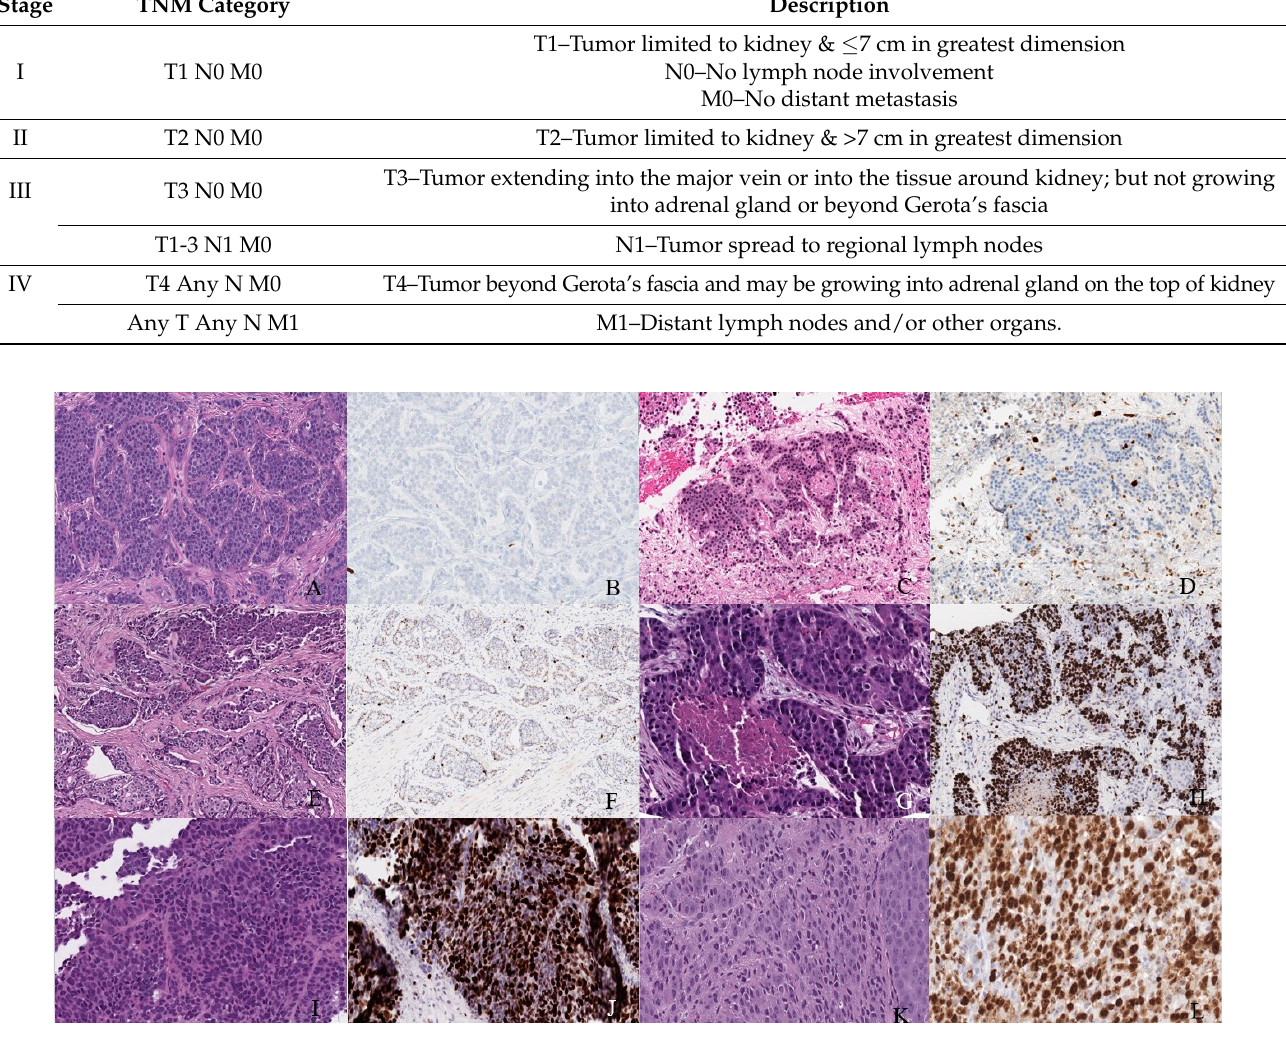
Figure 7. Well-differentiated NET (neuroendocrine tumor). ( A ) Grade 1 shows packets of neuroen- docrine cells separated by fibrovascular tissue. ( B ) Ki67 immunohistochemical stain shows a prolif- eration rate of 1%. Grade 2 well-differentiated NET showing ( C ) trabecular architecture. ( D )